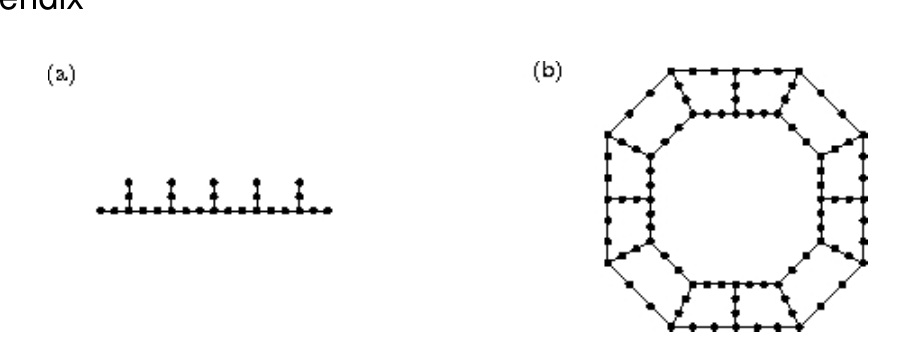
Fig. 2: ( a ) A tight example for the bound on the number of vertices in the maximum P 3 -packing in a subcubic graph ( d (3 n − 6) / 5 e ). ( b ) A tight example for the bound on the number of vertices in the maximum P 3 -packing in a 2 -connected (2 , 3) -regular graph ( d 3 n/ 4 e ).